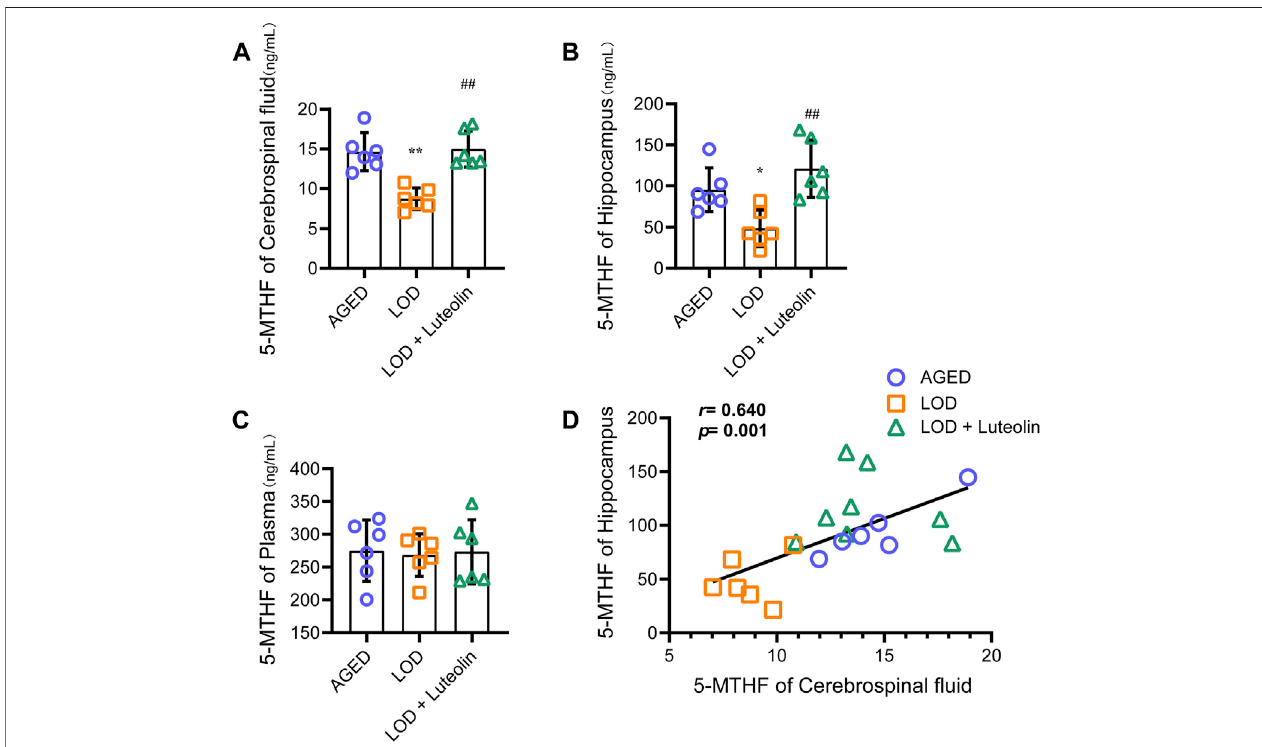
FIGURE 3 | Effects of luteolin on the plasma, CSF, and hippocampus 5-MTHF levels in LOD rats. The levels of the plasma, CSF, and hippocampus 5-MTHF are shown (A – C) ( n =6). (D) CorrelationanalysisoftheCSFandhippocampus5-MTHFlevels( n =6).Dataineachgroupwereconsistentwithanormaldistribution(Shapiro- Wilk test)andexhibitedhomogeneityofvariance; one-wayanalysisofvariance wasthenused forcomparisons. Dataareexpressed asthemean±SEM,* p < 0.05,** p < 0.01, vs. AGED; # p < 0.05, ## p < 0.01, vs. LOD.